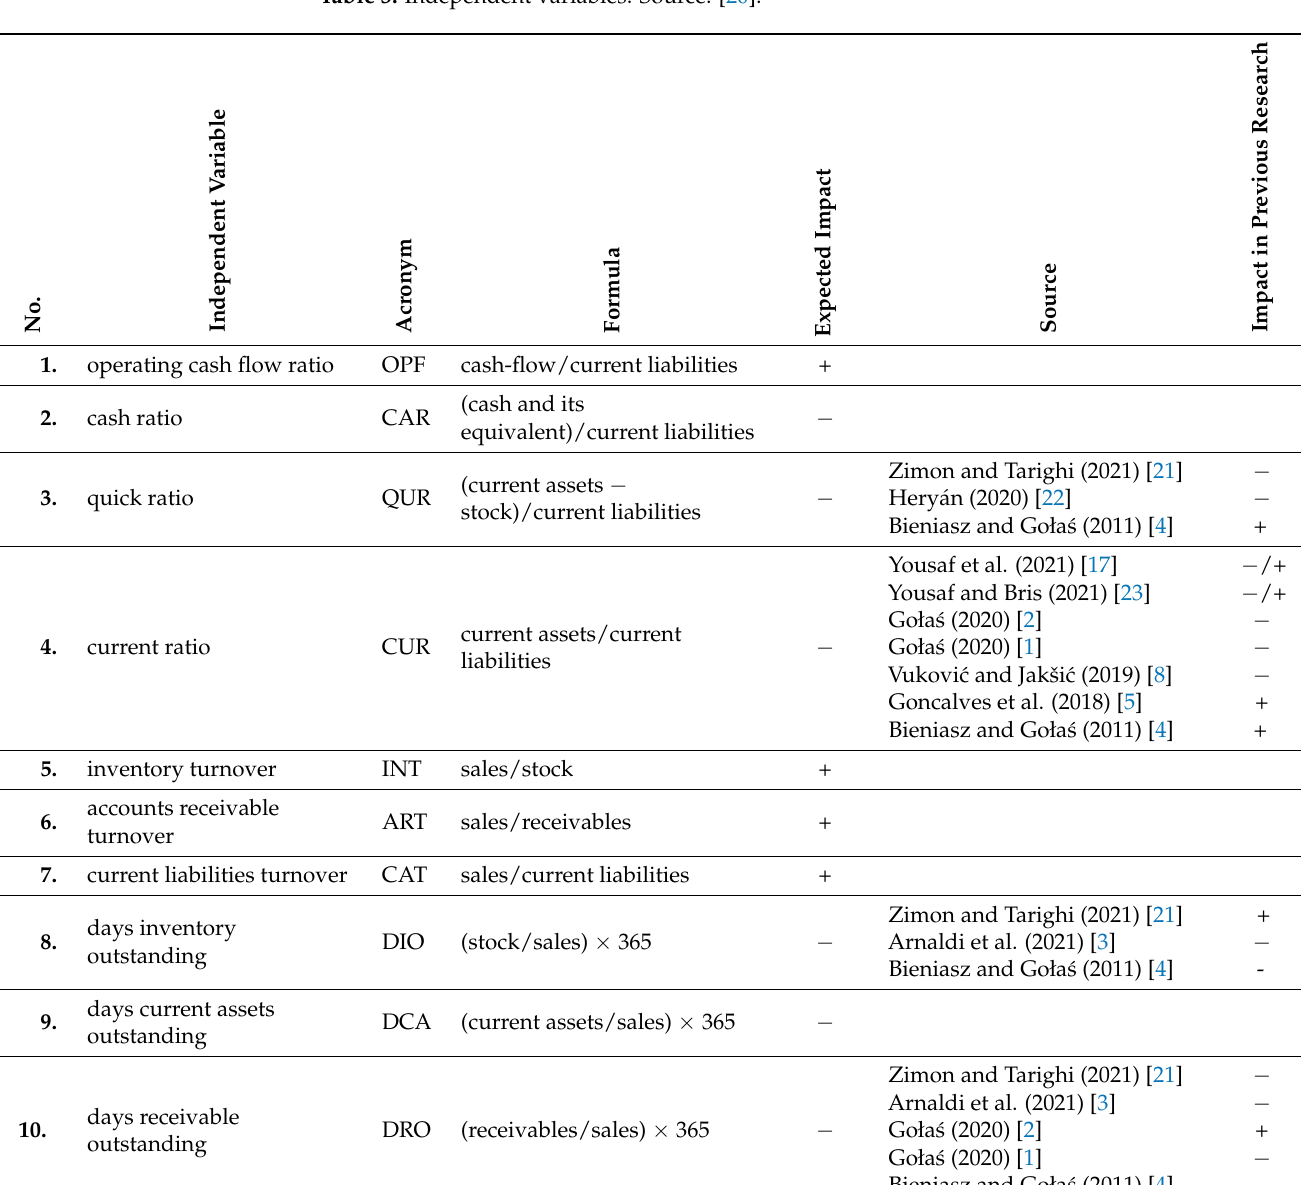
Table 3. Independent variables. Source: